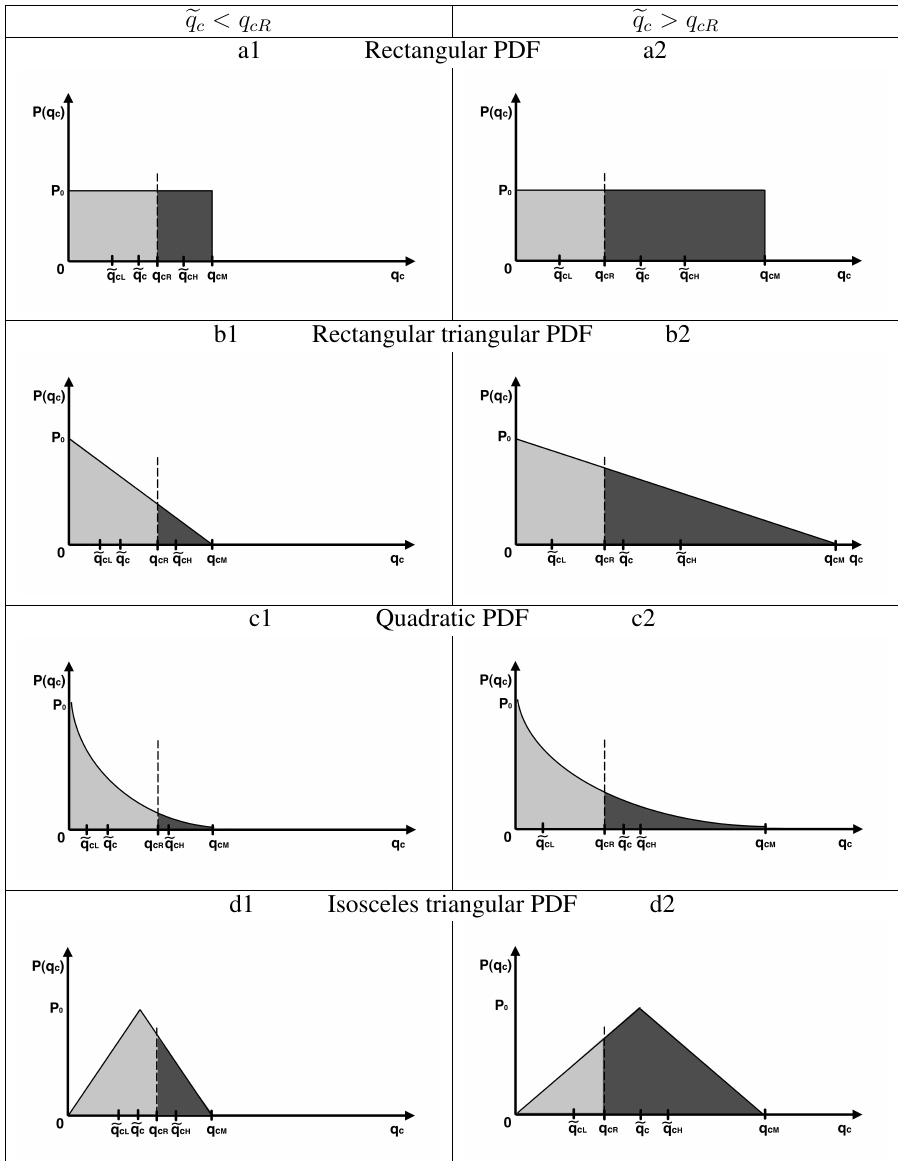
Figure 1: Graphs of the four PDF forms used to represent the CWC. Light grey represents regions of low CWC and dark grey represents high CWC. The local mean CWC, the local low CWC and local high CWC are, respectively, e q c , e q cL and e q cH . The autoconversion threshold is q cR , and the maximum value of the CWC is q cM .